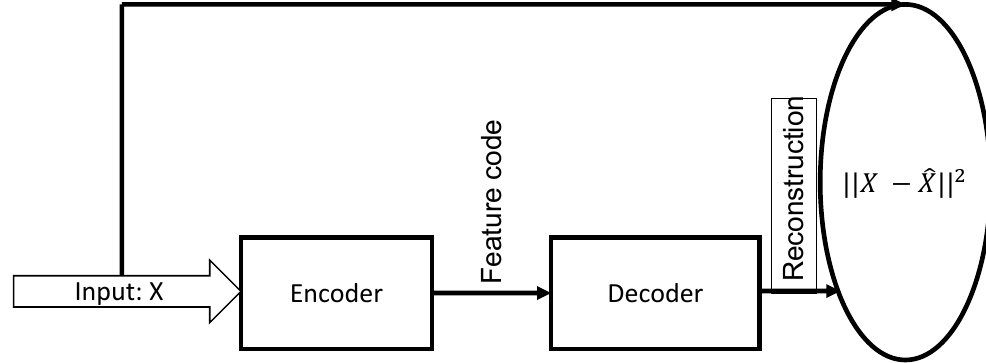
Figure 3. The general process of an AE